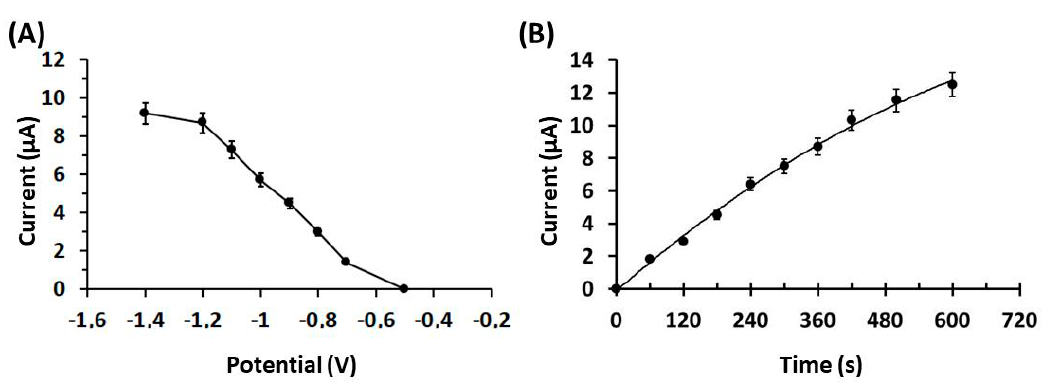
Figure 3. ( A ) E ff ect of the preconcentration potential (with respect to the carbon pseudo-RE) on the peak heights of 50 µ g L − 1 Pb(II) in 0.1 mol L − 1 acetate bu ff er (pH 4.5) at the Ca-MOF / GP. ( B ) E ff ect of the preconcentration time of 50 µ g L − 1 Pb(II) in 0.1 mol L − 1 acetate bu ff er (pH 4.5) at Ca-MOF / GP. The points in the plots are the mean value ± SD ( n = 4). Other DPASV parameters were pulse 40 mV for 10 ms and scan rate 10 mV s − 1 .